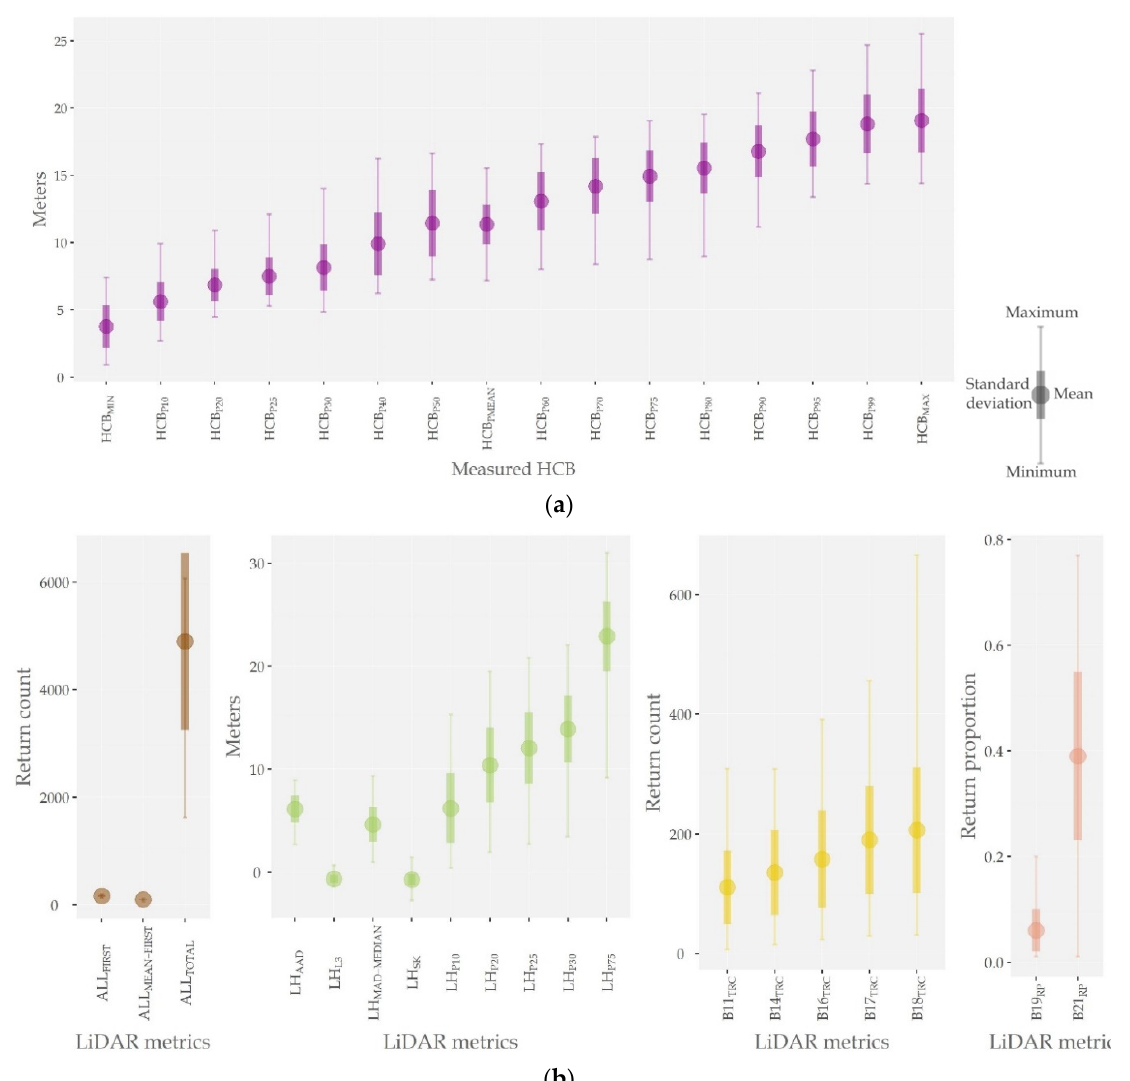
Figure 3. Statistical summary (mean, minimum, maximum and standard deviation) of ( a ) dependent variables (HCB M ) and ( b ) predictor variables (parameter) of the HCB models (see acronyms in Figure 2). Quantitative results were included in Table A1 (Appendix B).